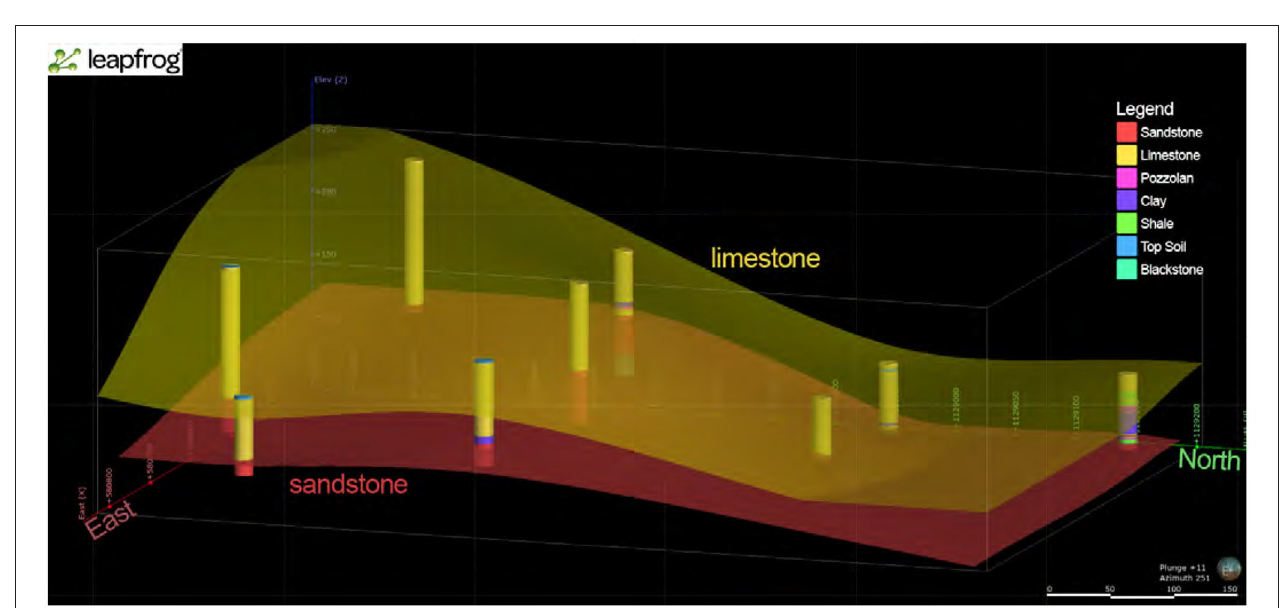
FIGURE 8 | Nine borehole data were modeled to show the lithology of the study area. A dipping layer of limestone lays on top of a sandstone layer.